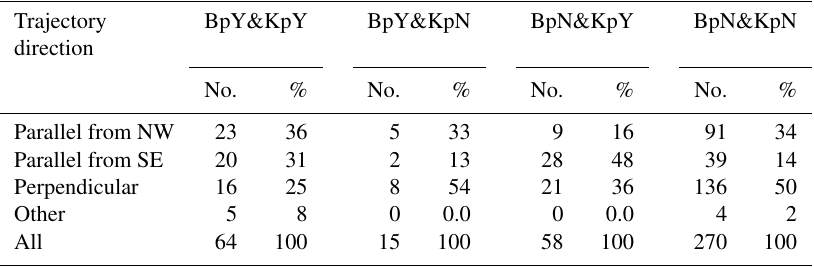
Table 2. Number and relative frequency of air mass trajectories arriving at the Budapest and K-puszta station in a parallel direction from NW and SE, in perpendicular directions, and in unclassified (other) directions relative to the Budapest–K-puszta station geographical connecting line when there were NPF events identified at both sites (BpY&KpY), an event in Budapest and no event at the K-puszta station (BpY&KpN), no event in Budapest and an event at the K-puszta station (BpN&KpY), and no event at either of the sites (BpN&KpN). Trajectory BpY&KpY BpY&KpN BpN&KpY BpN&KpN direction No. % No. % No.